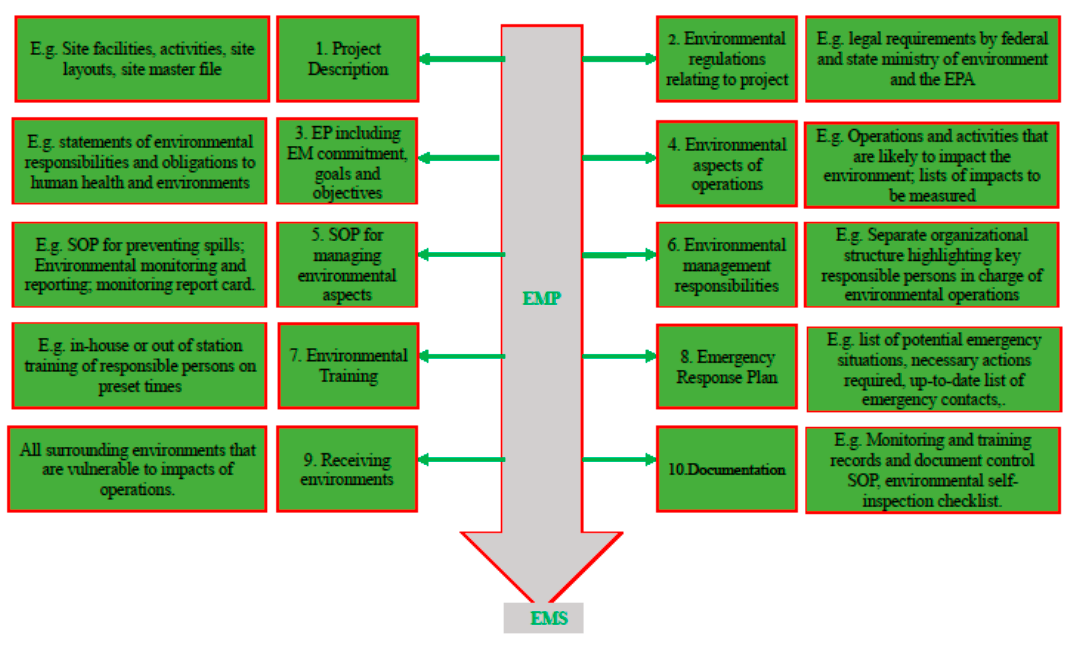
Figure 3. EMP components. EP = environmental policy; SOP—standard operating procedure; EMS—